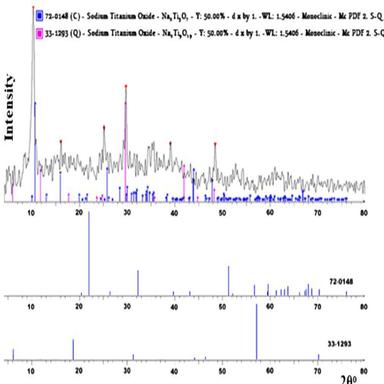
XRD patterns of two forms the titanate nanofibers.